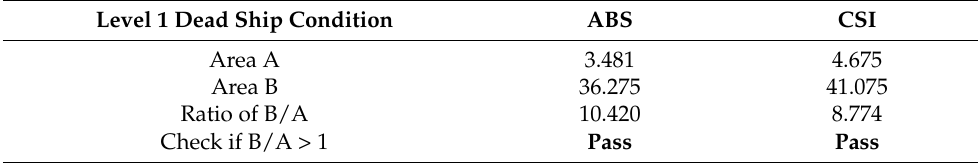
Table 15. Level 1 assessment of dead ship failure mode for C11 container ship.